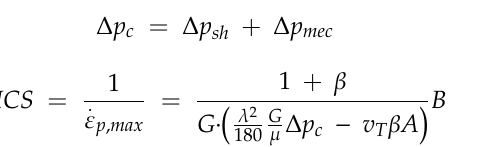
Figure 3. HCS (A) of different aluminum alloys.